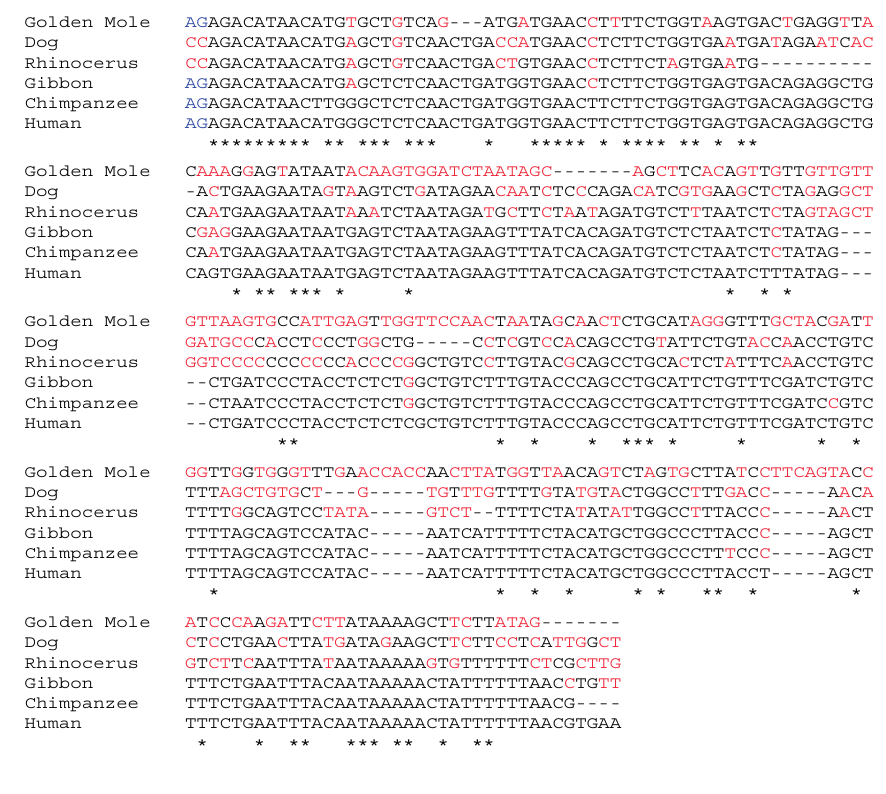
Figure 2. Multiple alignment of the human NK2 3'UTR with predicted 3'UTR sequences from species using the European Molecular Biology Laboratory—European Bioinformatics Institute Clustal Omega program [45]. Asterisks indicate nucleotides identical with the human sequence; non-identical nucleotides are shown as red letters. The first two nucleotides (AG, blue) are the predicted primate splice acceptor